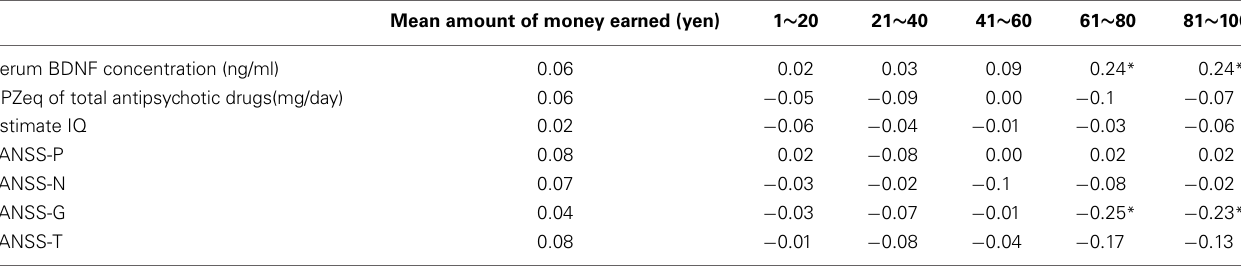
Table 3 | Correlation between the Iowa Gambling Task performance and serum BDNF, estimated IQ, and clinical symptoms. Mean amount of money earned (yen)